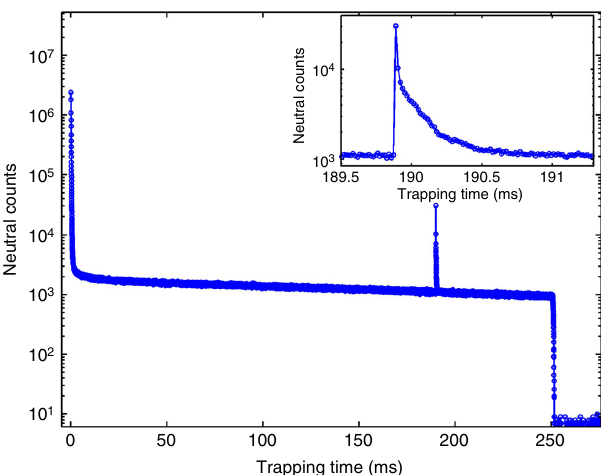
counts as a function of trapping time. Ions were Fig. 2 Neutralized C (cid:1) 10 trapped and a laser pulse of 2.85 eV photons was admitted ~190 ms afterwards. Trapping was stopped after 250 ms and the cycle repeated. The data shown is from ~10 5 such trapping cycles. The high number of counts during the fi rst few milliseconds is due to spontaneous electron emission from the vibrationally and rotationally hot C (cid:1) . During this time, C (cid:1) also 10 10 undergoes radiative cooling and spontaneous electron emission stops. The neutral counts after this time are due to loss of an electron upon collision of the trapped ions with the residual gas. The counts after 250ms are due to MCP noise. The peak at ~190 ms is produced by neutrals formed due to delayed detachment of electrons. The inset shows an enlargement of this peak, which clearly depicts formation of neutrals with signi fi cant delay relative to the laser interaction